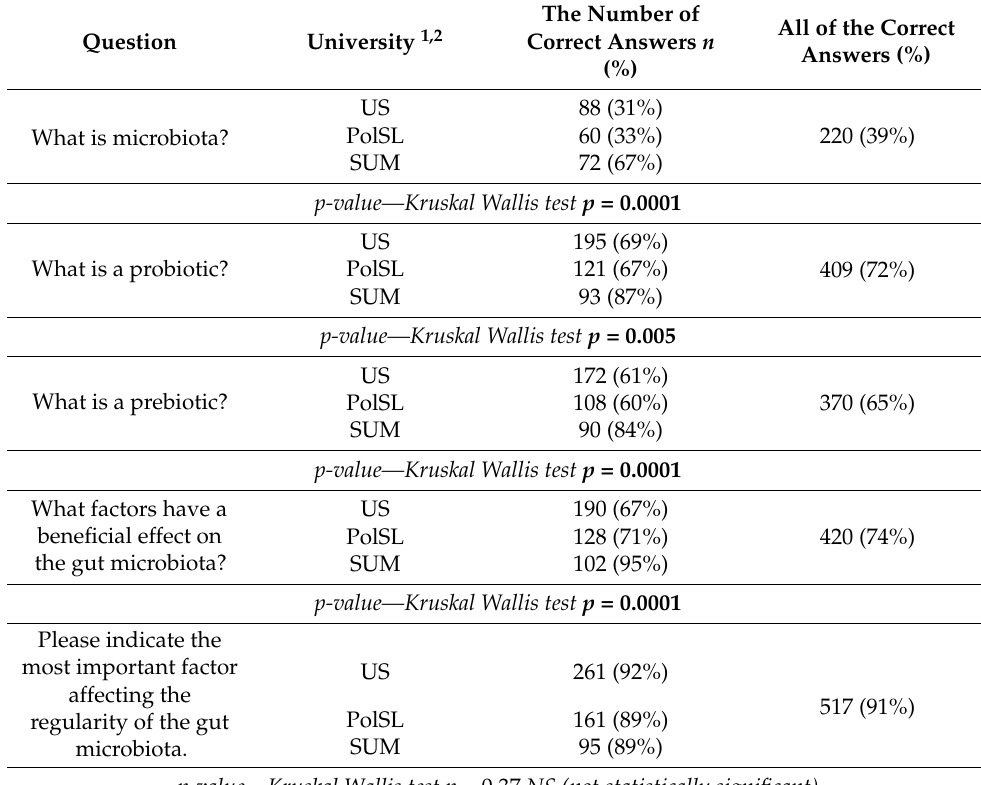
Table 2. The number of correct answers in the field of microbiota depends on the university where the respondents studied. (Single-choice questions). Source: own